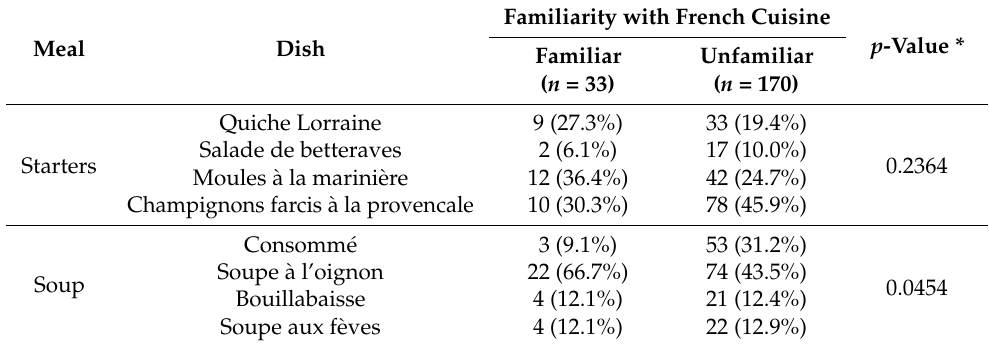
Table 8. The dish choices made by the studied sample of young Polish women from the model French restaurant menu, stratified according to their familiarity with French